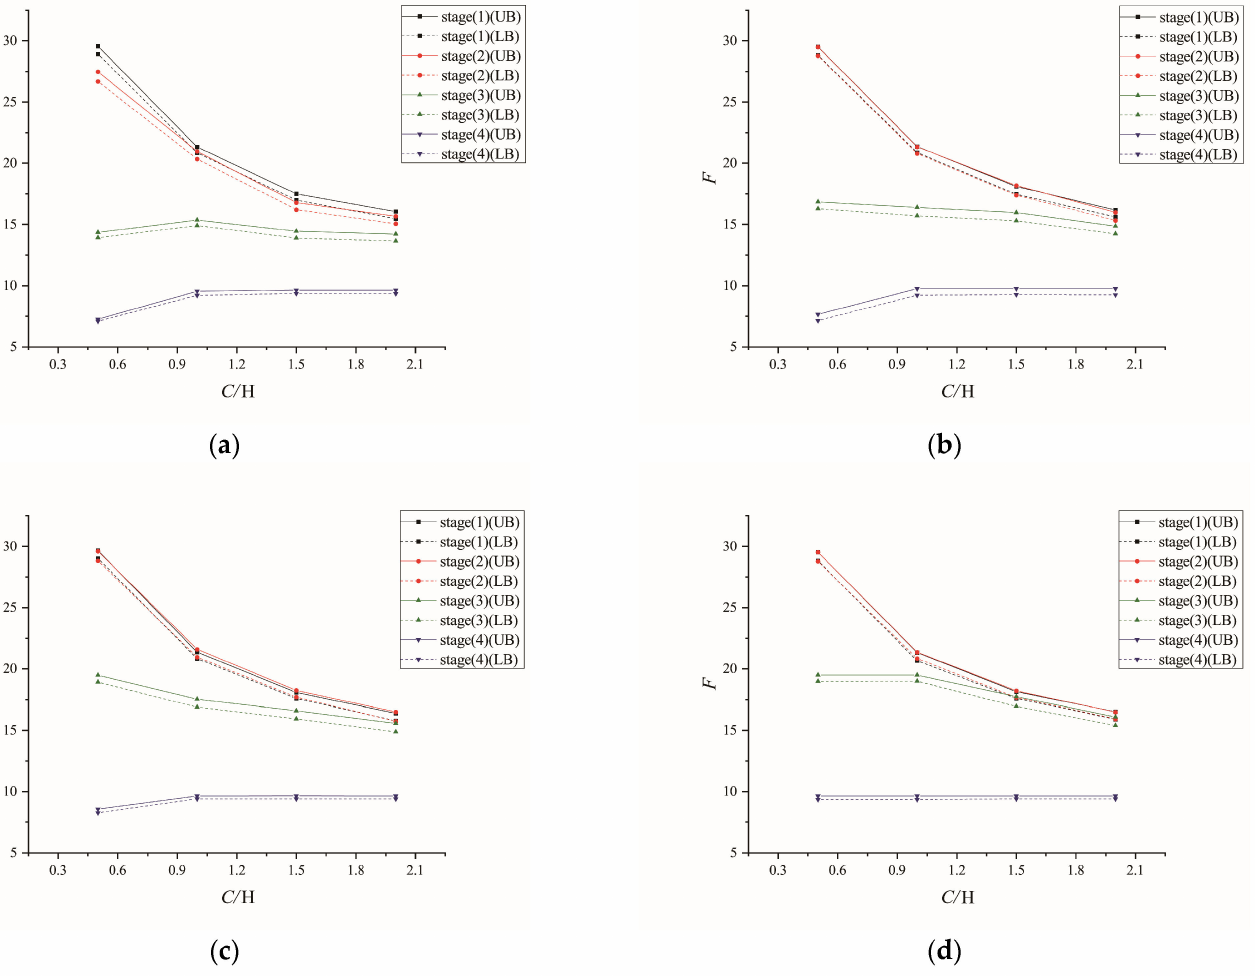
Figure 19. Influence of C on the safety factors F of global stability under different horizontal distance L : ( a ) L = 0.33 H, ( b ) L = 0.5 H, ( c ) L = 0.67 H and ( d ) L = 1.0